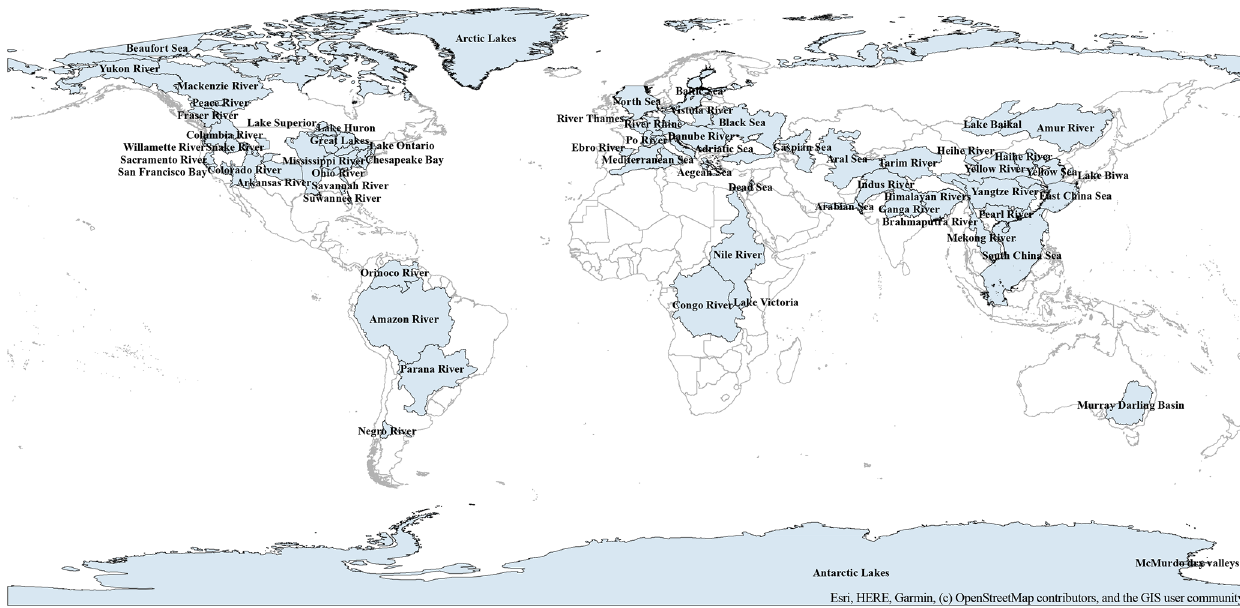
Figure 2. The spatial locations of the 95 river basins used for